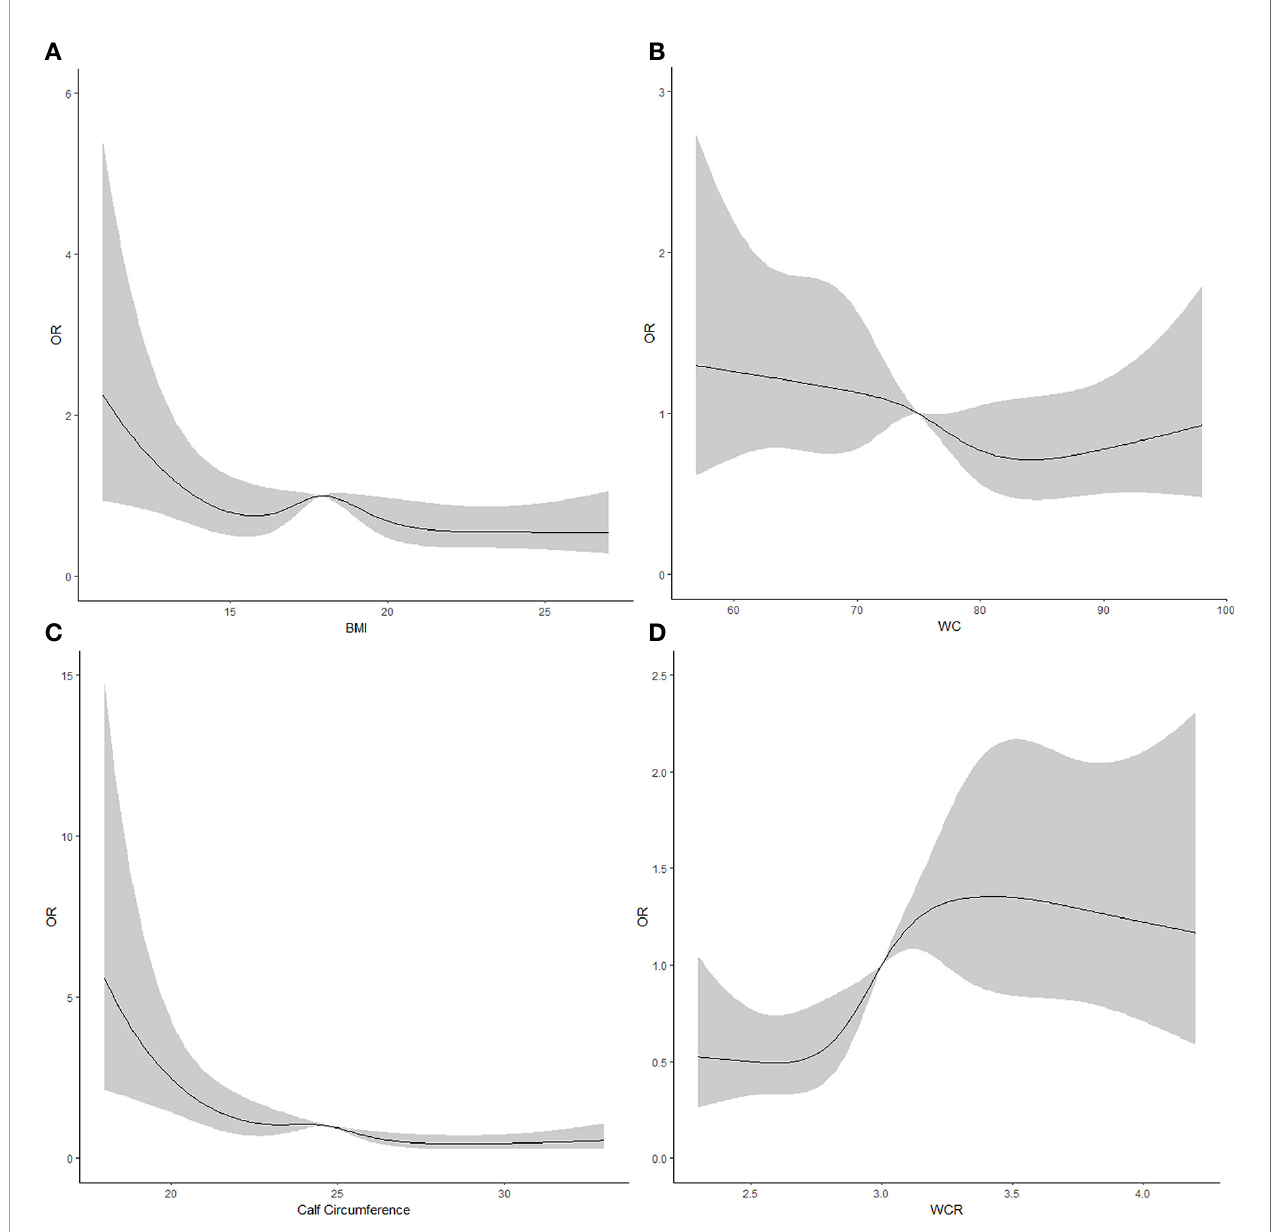
FIGURE 2 | Restricted cubic splines assessing the association between (A) body mass index, (B) waist circumference, (C) calf circumference, and (D) waist-calf circumference ratio and the risk of severe instrumental activity of daily living disability after adjusting for gender, age, ethnicity, educational level, residential type, smoking, drinking, and physical